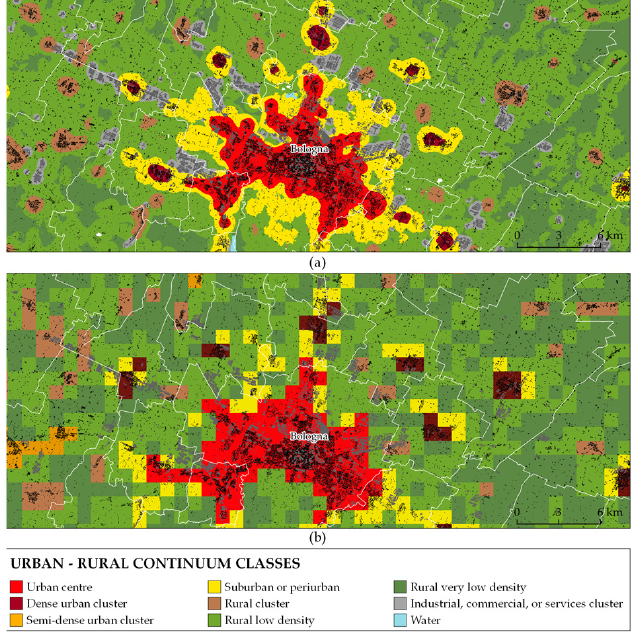
Figure 4. Urban area of Bologna: comparison between ( a ) classification of the urban–rural continuum from the proposed data (2018) and ( b ) GHS-SMOD (2020). The two data are consistent with regard to the distribution of the different classes; however, the proposed data represent with higher geometric detail the edges of dense urban centers and the spatial configuration of small and medium-sized clusters that have developed around the main metropolitan areas.